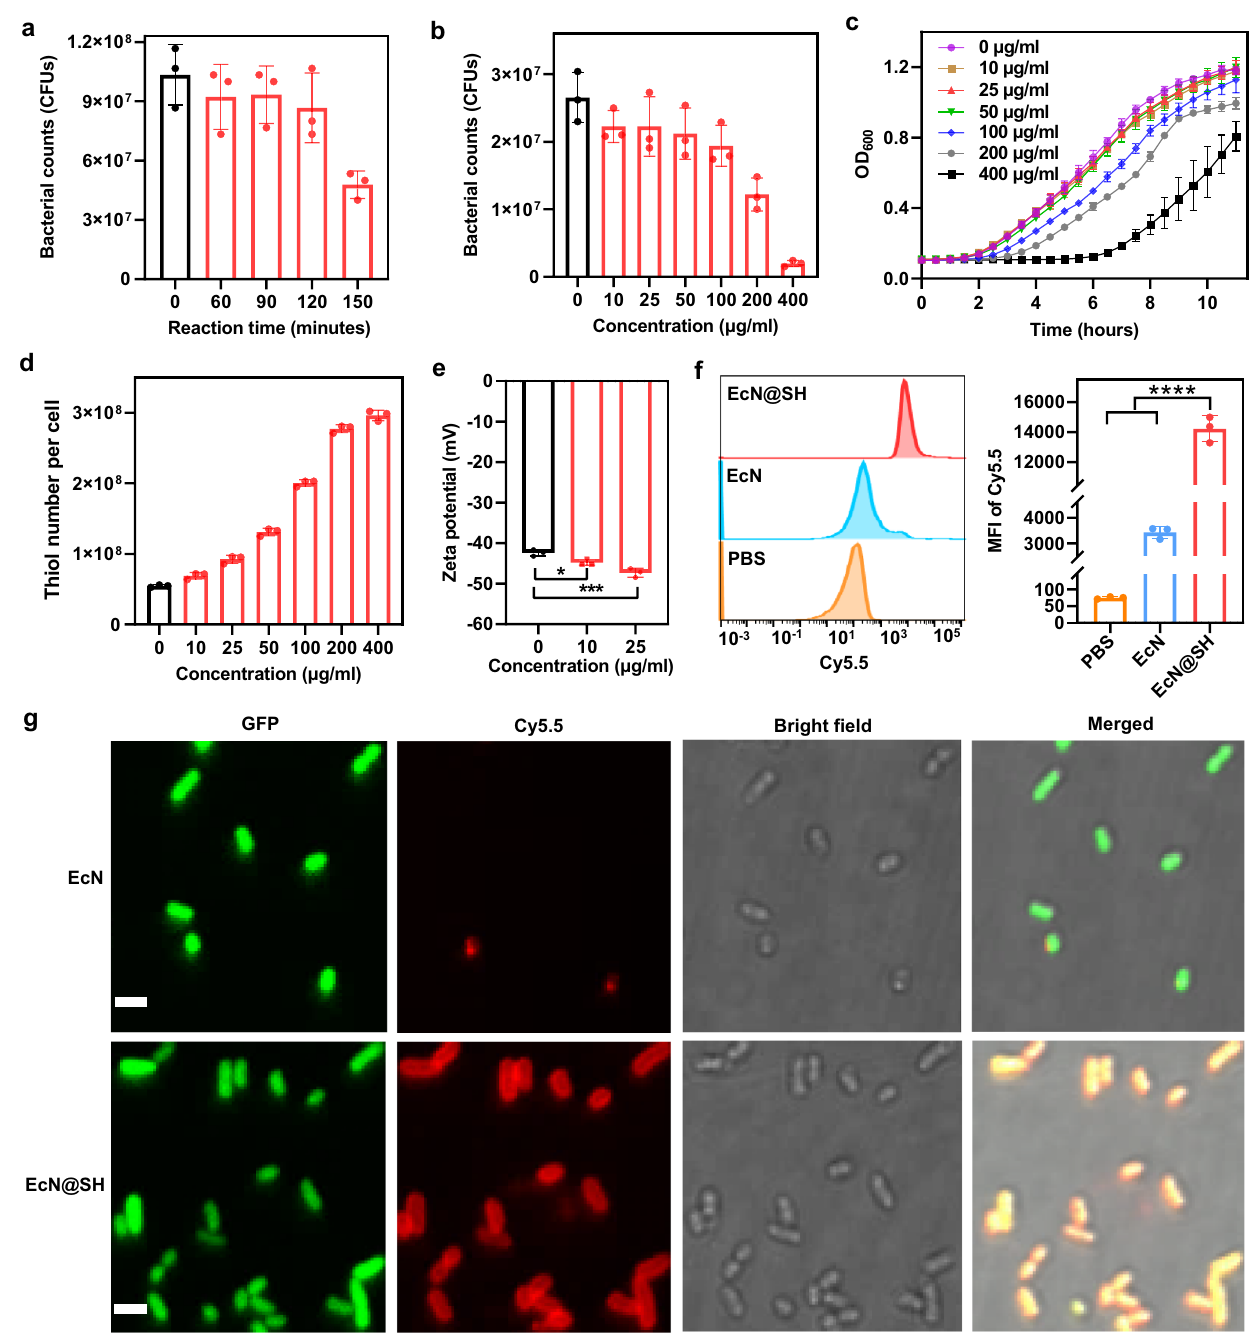
Fig. 2 | Preparation, characterization, and reactivity of surface-thiolated bac- teria.a SurvivalofEcNafterreactionwith2-iminothiolaneforvariedtimeintervals, including 60,90,120, and 150min. b Survival, c growth curves, and d surfacethiol numbers of EcN after reaction with different concentrations of 2-iminothiolane ranging from 0 to 400 µ g/ml for 90min. e Zeta potentials of EcN after thiolation with different concentrations of 2-iminothiolane. f Flow cytometryhistograms and MFI values of native EcN and EcN@SH post reaction with Cy5.5-maleimide for